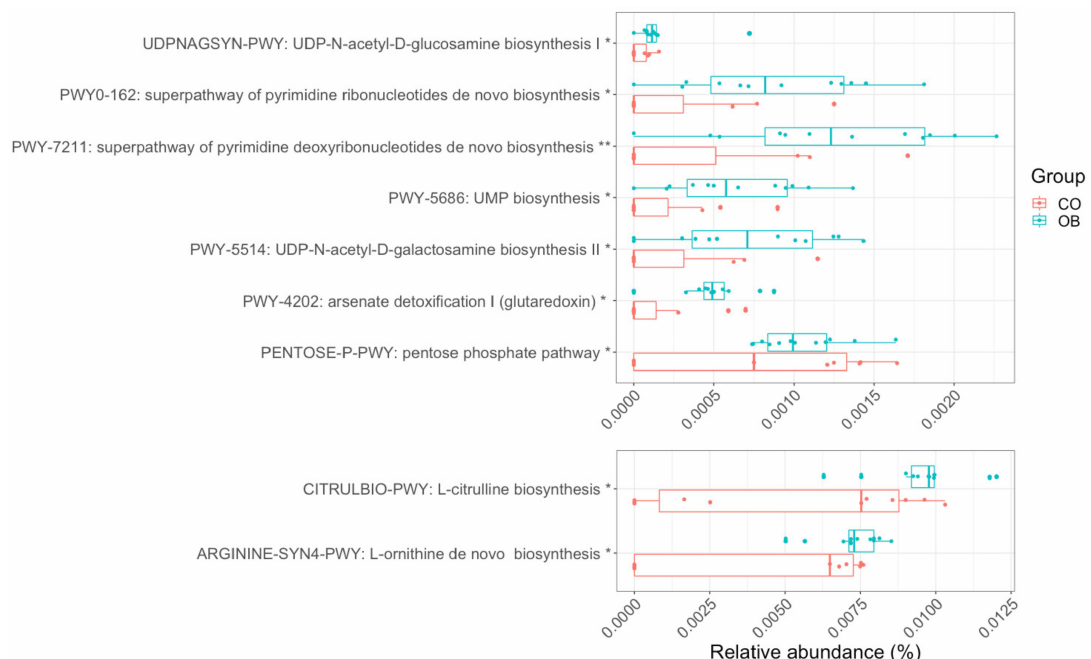
Figure 5. MetaCyc microbial processes associated with obesity (q < 0.1) detected using the MaAsLin2-generalized linear model. The significance was calculated after adjusting for age and gender e ff ects. The x-axis shows the relative abundances. Boxplots were made with R function boxplot with default settings (whiskers extend 1.5-times the interquartile range). (*: 0.05 < q < 0.1: **: 0.01 < q < 0.05). Red and Cyan boxplots indicate Lean (CO, n = 11) and Obese (OB, n = 12) samples,